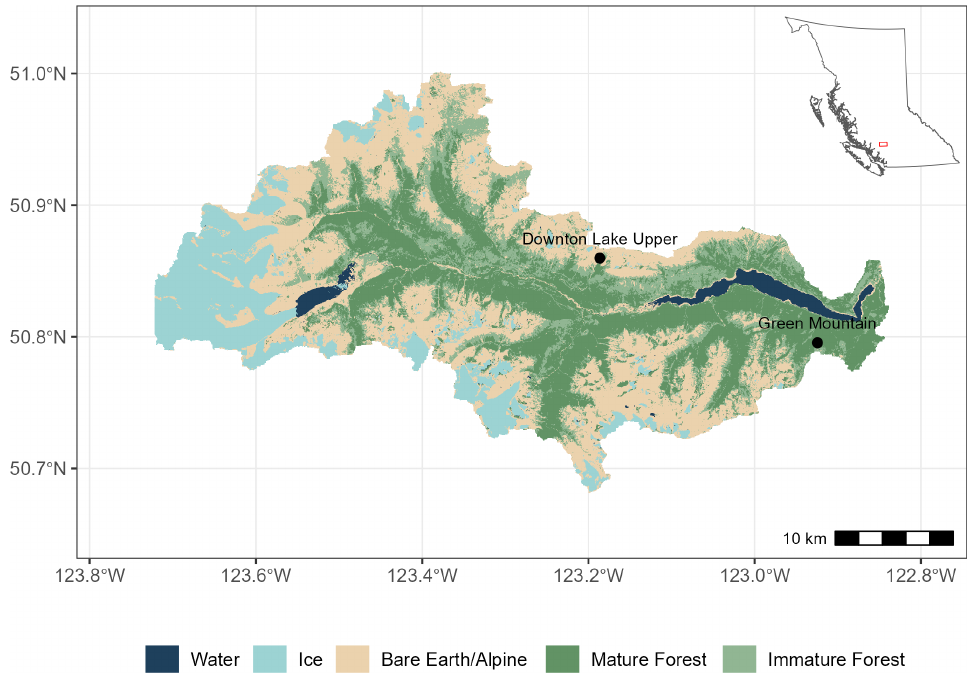
Figure 1. The La Joie Basin by land cover type. Land cover types were determined via a random forest classification in Google Earth Engine from Sentinel-2